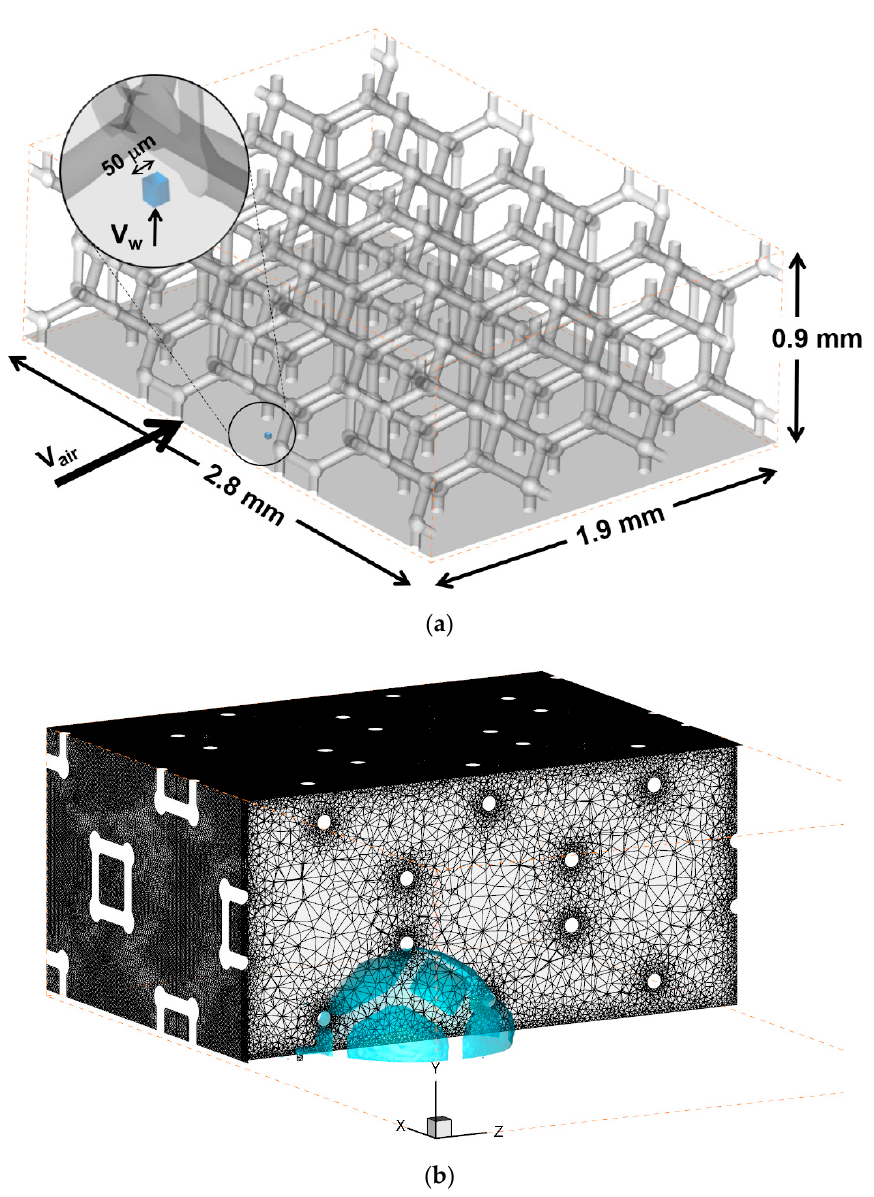
Figure 3. Numerical model ( a ) Computational domain, ( b ) Mesh.